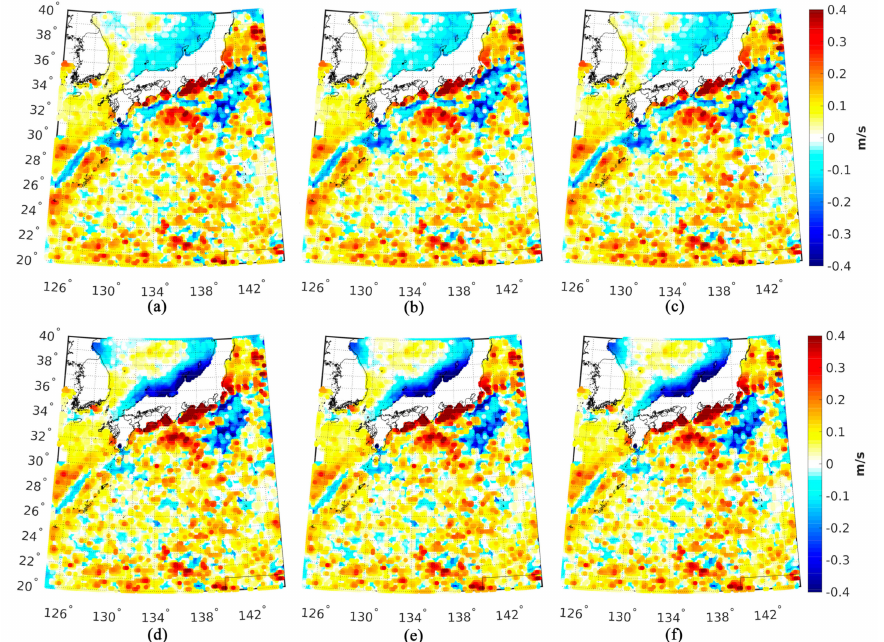
Figure 9. The differences in zonal geostrophic velocities between buoy data and information deduced from the MDT solutions: ( a ) DTU18DIRR4-MDT; ( b ) DTU18DIRR5-MDT; ( c ) DTU18DIRR6-MDT; ( d )